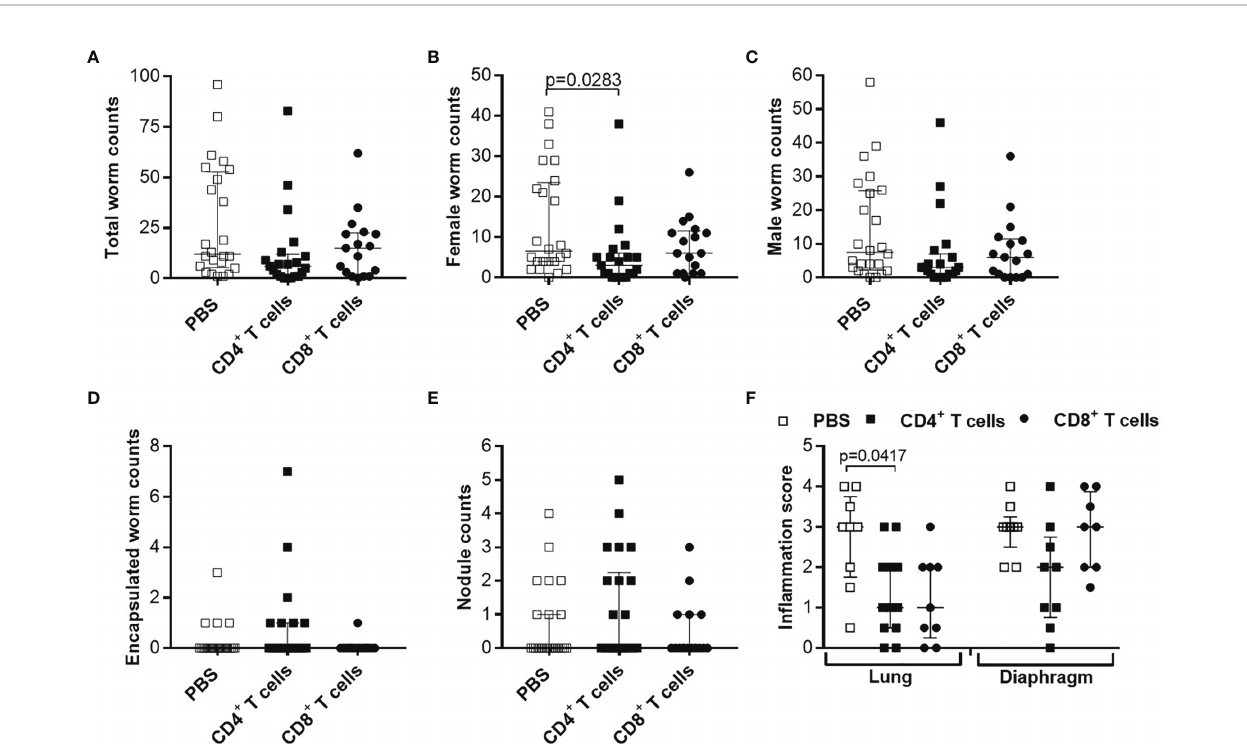
FIGURE 1 | Adoptive transfer of naïve T cells do not alter parasite burden and thoracic cavity pathology in L. sigmodontis -infected RAG2IL-2R g -de fi cient C57BL/6 mice. CD4 + or CD8 + T cells from naïve C57BL/6 donor mice were injected intravenously (i.v.) into the tail vein of RAG2IL-2R g -de fi cient C57BL/6 mice one day prior to L. sigmodontis infection. On day 72 p.i. mice were analysed to assess (A) total, (B) female, (C) male and (D) encapsulated worm counts as well as (E) nodule counts in the thoracic cavity. In addition, H&E-stained lung and diaphragm sections were microscopically analysed to assess the (F) in fl ammation score. Graphs show dot blots with median and interquartile ranges from individual mice from (A – E) four independent experiments including (no adoptive transfer (PBS; n=25) and adoptive transfer of CD4 + (n=21) and CD8 + T cells (n=17) and (F) two independent experiments including PBS (n=9) and adoptive transfer of CD4 + (n=12) and CD8 + T cells (n=9) into RAG2IL-2R g -de fi cient C57BL/6 mice. Signi fi cant differences between the groups were determined by Kruskal-Wallis-test followed by a Dunn ’ s multiple comparison